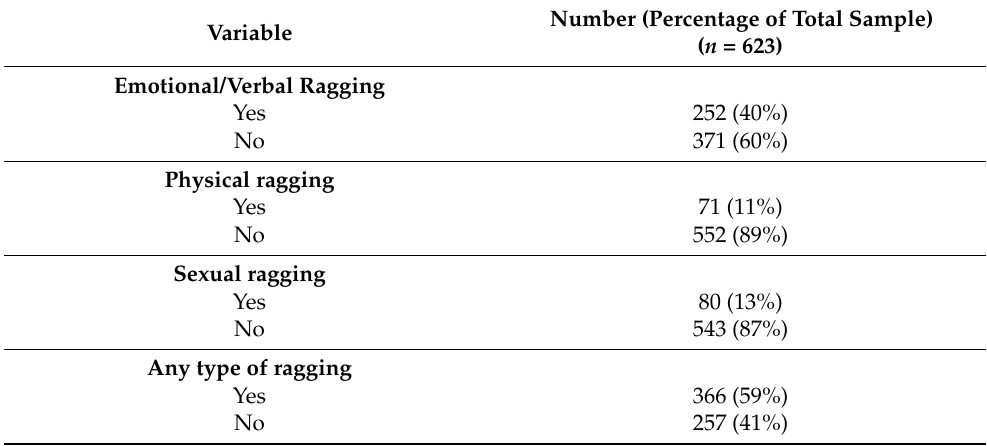
Table 2. Types of Ragging experienced by the second- and third-year students from the faculties of medicine and technology.